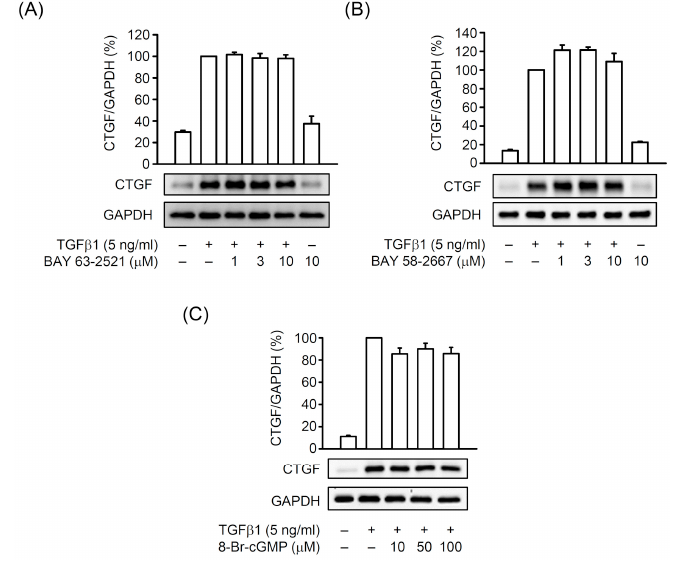
Figure 7. Effects of BAY 63-2521, BAY 58-2667, and 8-Br-cGMP on TGF β 1-induced CTGF expression in HSCs. HSCs were preincubated with ( A ) BAY 63-2521 (1–10 μ M), ( B ) BAY 58-2667 (1–10 μ M), or in HSCs. HSCs were preincubated with ( A ) BAY 63-2521 (1–10 µ M), ( B ) BAY 58-2667 (1–10 µ M), or ( C ) 8-Br-cGMP (10–100 µ M) for 30 min before activation by TGF β 1 (5 ng / mL) for another 6 h. Expressed CTGF and GAPDH were determined by Western blot using the corresponding antibodies. All data are expressed as mean ± SD ( n =